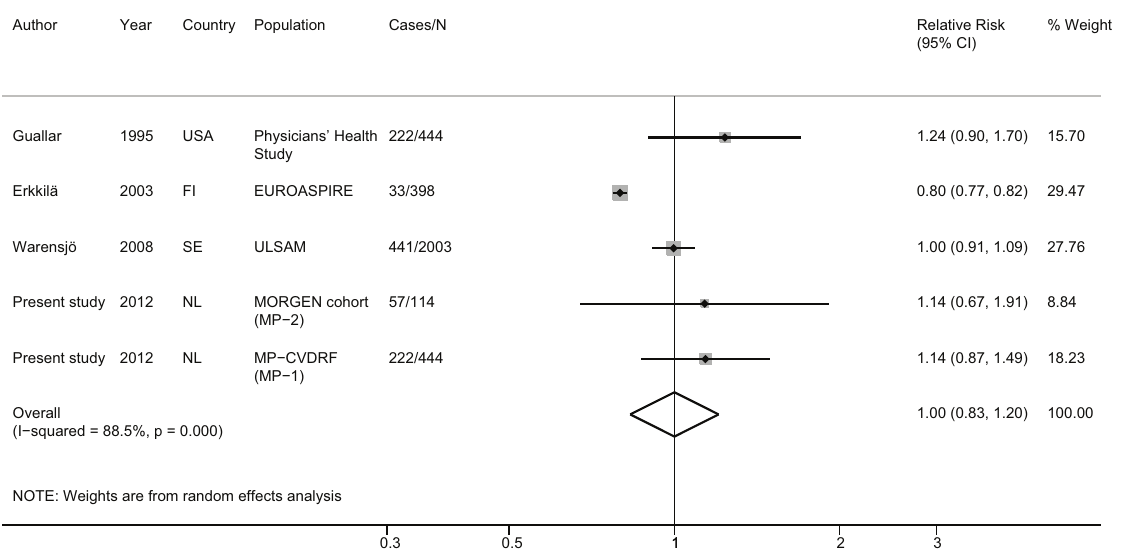
Figure 6. Pooled relative risk of cholesterol ester docosahexaenoic acid and CHD risk.